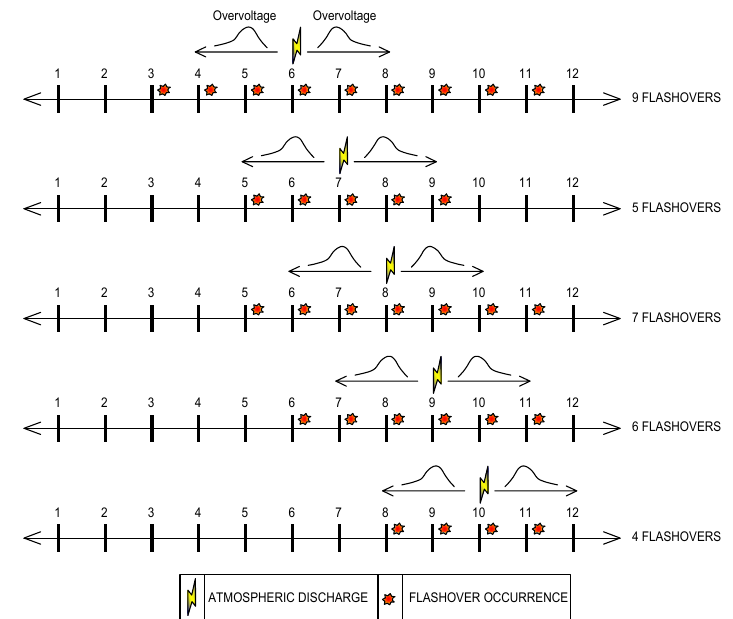
Figure 8. Flashover occurrences for different lightning discharge incidence in a 12 poles distribution